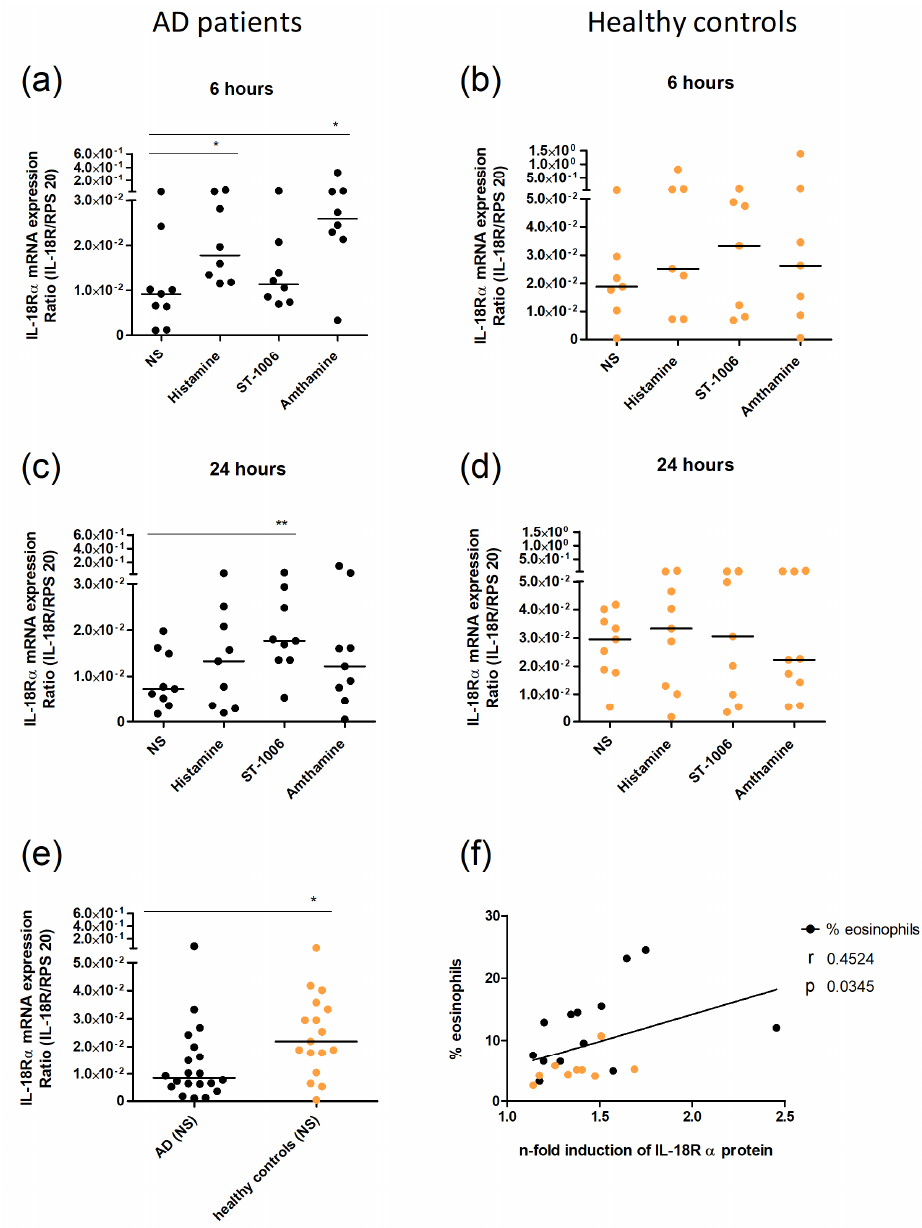
Figure 2. IL-18Rα expression in eosinophils compared between AD patients and healthy controls after stimulation with histamine, ST-1006, and amthamine. ( a – d ) Eosinophils from AD patients (black) and healthy controls (orange) were stimulated with histamine (10 μmol/L), the H 4 R agonist ST-1006 (10 μmol/L), and the H 2 R agonist amthamine (10 μmol/L) for 6 h ( a , b ) or 24 h ( c , d ) or were left unstimulated (NS). The expression level of IL-18Rα was measured at mRNA level by real-time PCR. ( e ) The constitutional IL-18Rα mRNA expression of non-stimulated (NS) purified eosinophils from AD-patients (black) and healthy controls (orange) is shown. ( f ) Eosinophils were stimulated with histamine (10 μmol/L) for 20 h and IL-18Rα expression was measured by flow cytometry. The extent of histamine-induced IL-18Rα expression (n-fold induction of IL-18Rα protein expression) was correlated with the number of eosinophils in the blood of each subject for statistical analysis, a Mann–Whitney test ( e ), a Spearman correlation ( f ), and a Wilcoxon signed rank test ( a – d ) were applied. * p -value < 0.05; ** p -value < 0.1. NS—not stimulated, AD—atopic dermatitis.